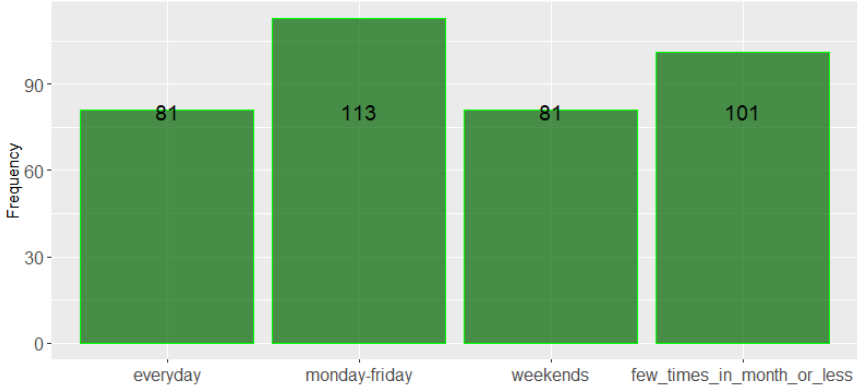
Figure 1. Frequency of recreational activity among respondents.